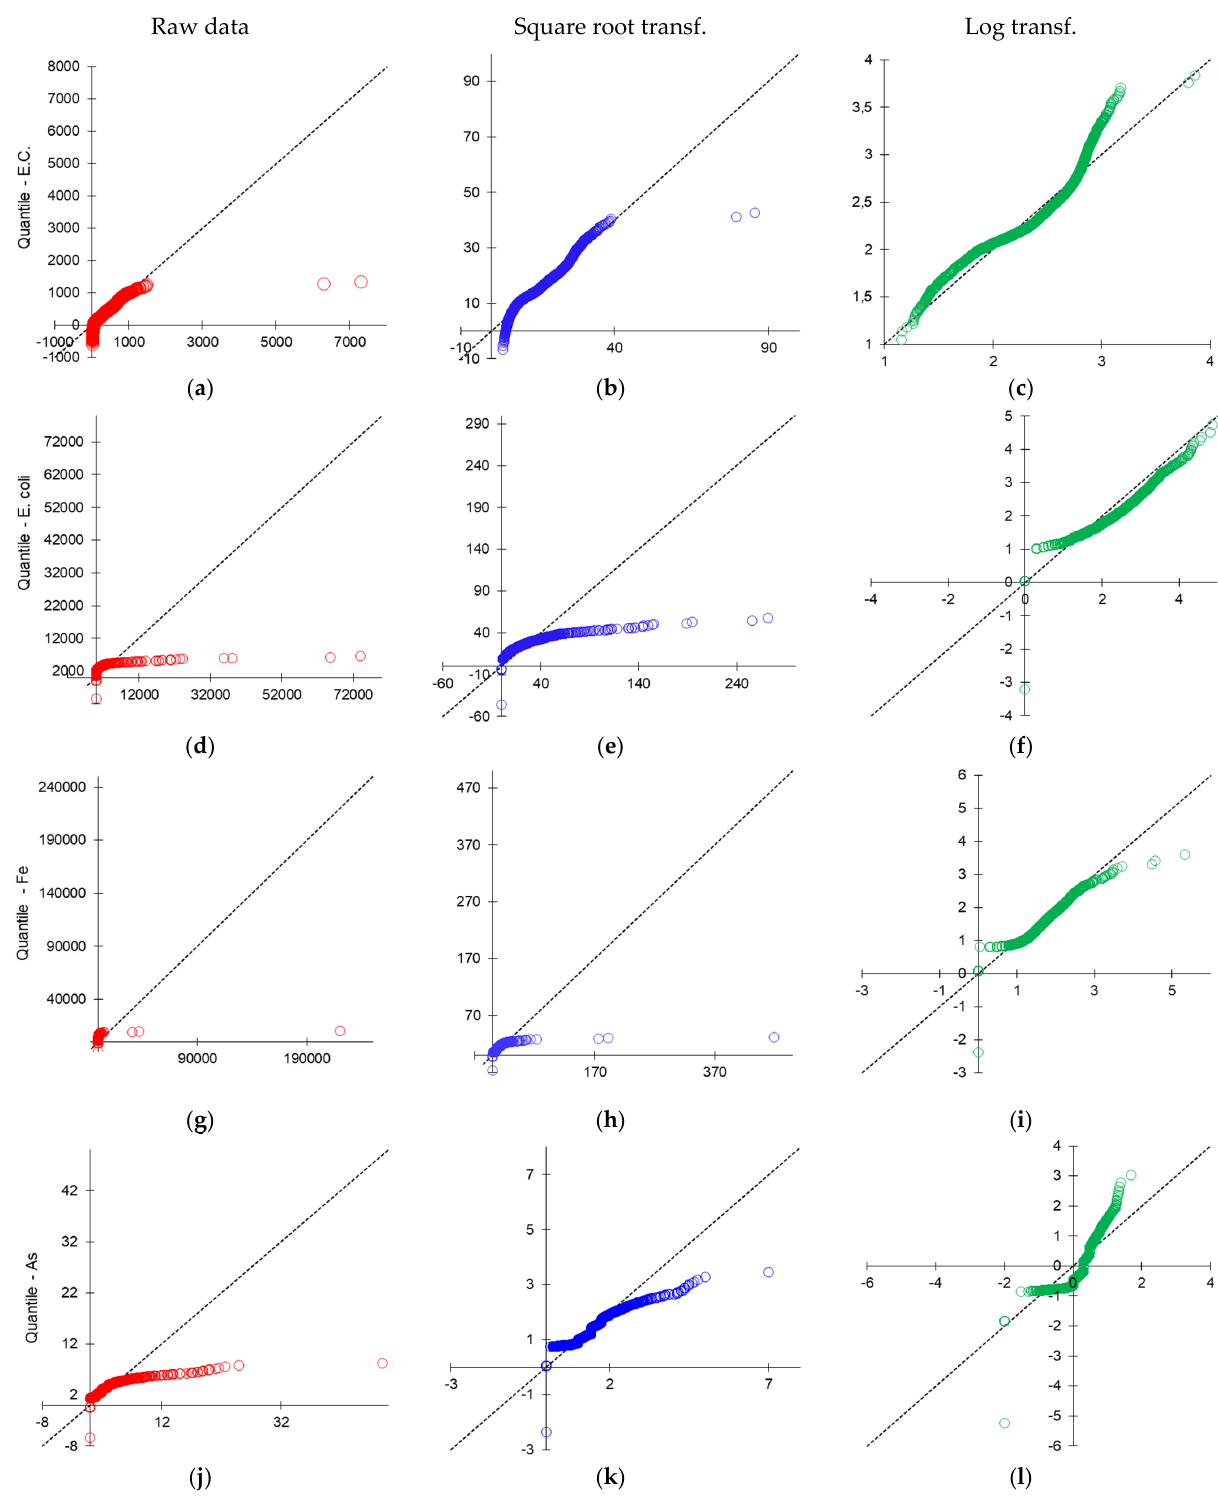
Figure 5. Quantile ‐ quantile plots for Electrical Conductivity ( a – c ), E. coli ( d–f ), Fe ( g – i ) and As ( j – l ) for raw, square root ‐ and log ‐ transformed data.